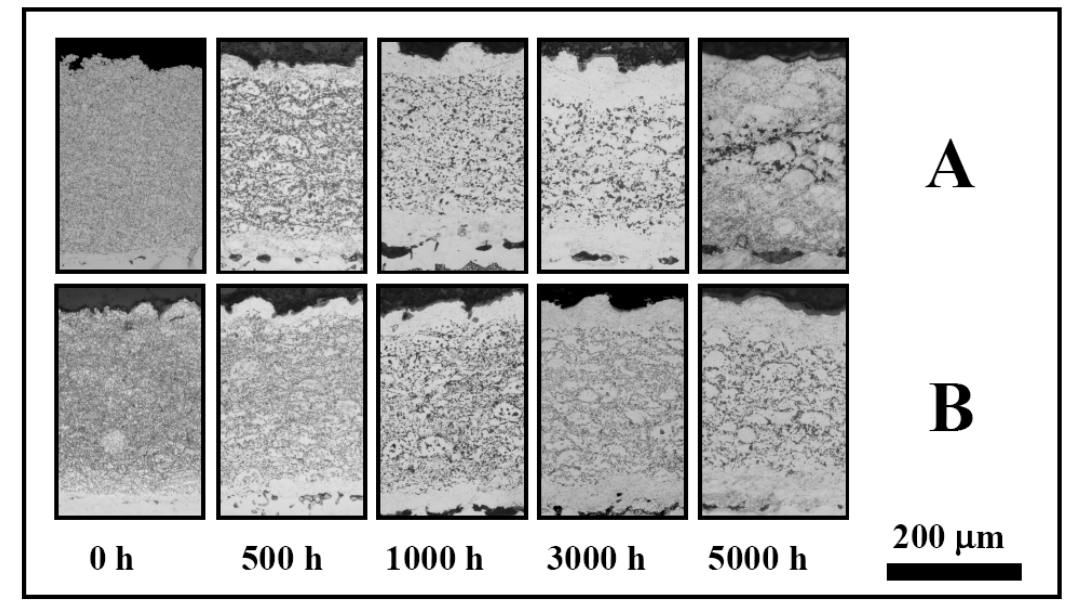
Figure 4. Optical micrographs of the cross sections of the samples produced with powder A and B after different periods of oxidation at 1,273